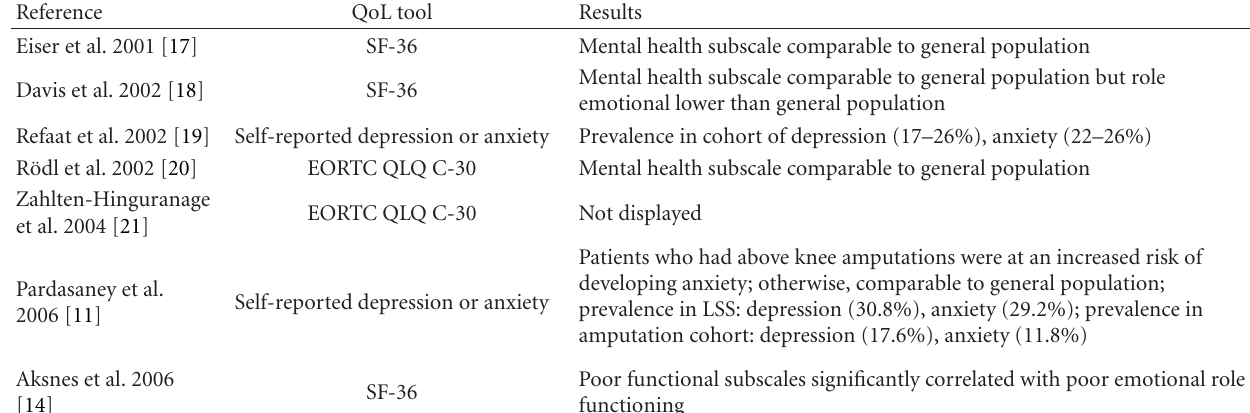
Table 8: Summary of mental health in extremity sarcoma patients—a reflection from QoL